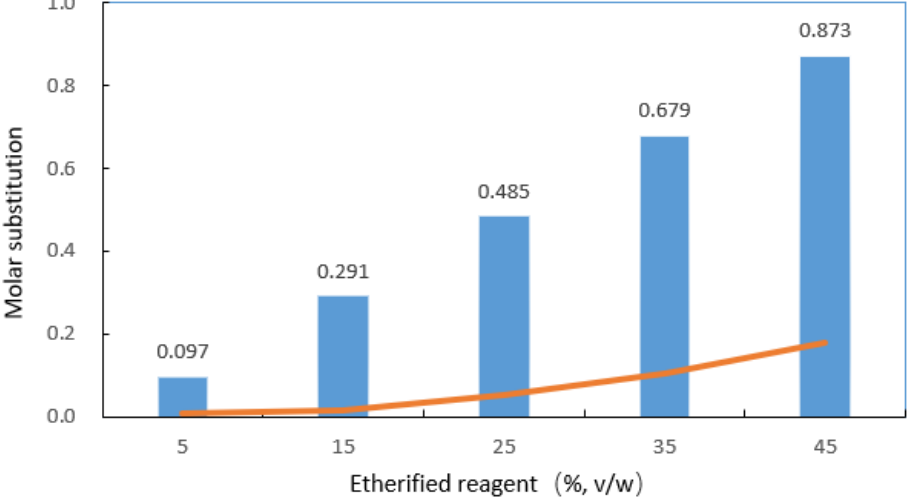
Figure 1. Effect of etherified reagent on molar substitution of hydroxypropylated starches. (Histogram is theoretical MS, trendline is experimental MS).